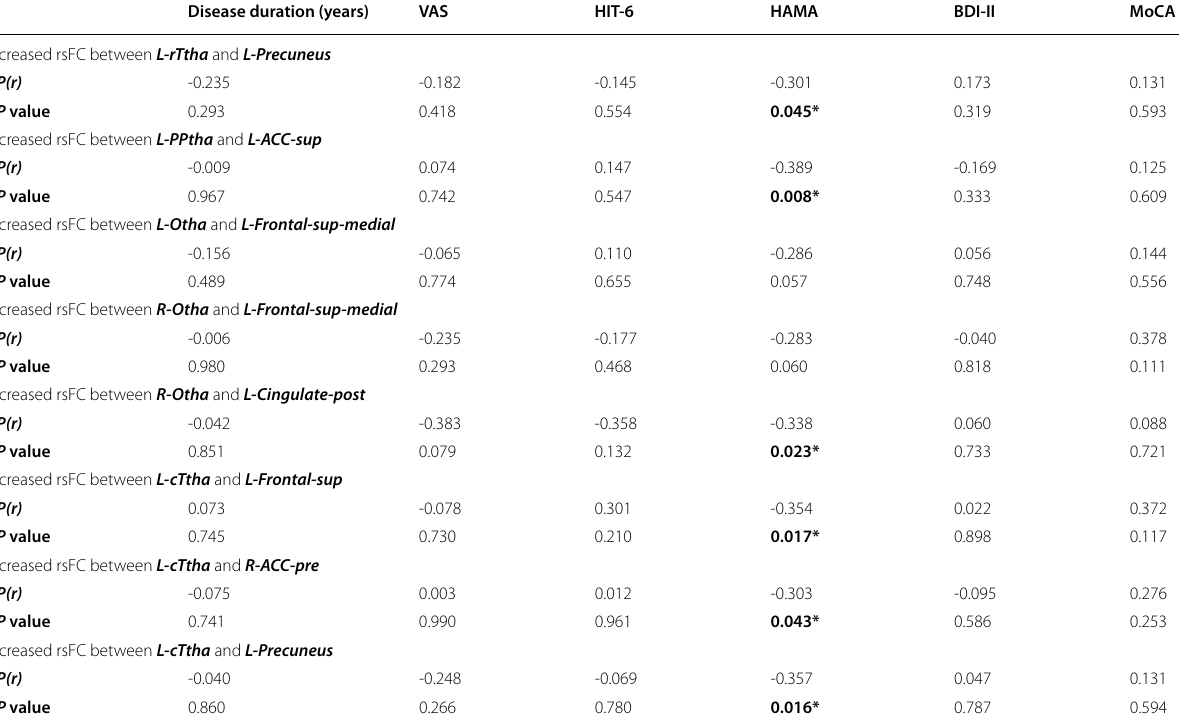
Table 5 Partial correlations between decreased rsFC and clinical data in patients with episodic migraine after controlling for age, sex, education, and